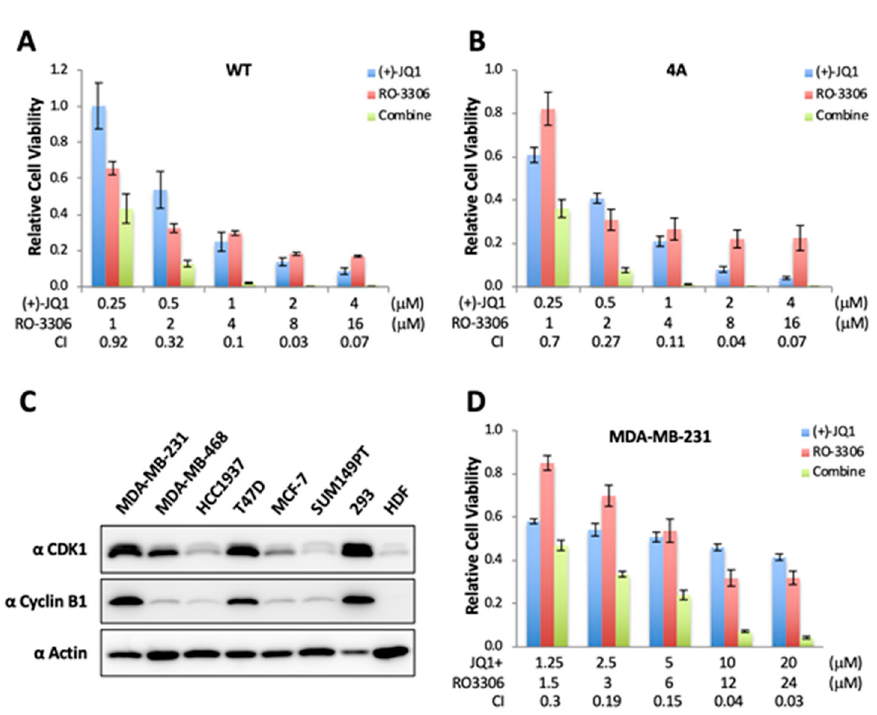
Figure 5. BETi and CDK1 inhibitor show synergistic e ff ects in killing cancer cells. ( A , B ) DLD-1 cells with CRISPRed BRD4-AID and Flp-In BRD4 WT ( A ) or 4A ( B ) were incubated with Dox and IAA for 1 day before treating with DMSO or the indicated doses of ( + )-JQ1, RO-3306 or a combination of both drugs. CellTiter-GLO cell viability assays were performed 3 days after drug treatment. Relative cell viability was determined by normalizing the drug treatment values to the DMSO control values. ( C ) Whole cell lysates of indicated breast cancer cells together with 293 and HDF cells were resolved in SDS / PAGE and immunoblotted with the indicated antibodies. ( D ) MDA-MB-231 cells were treated with DMSO or the indicated doses of ( + )-JQ1, RO-3306 or a combination of both drugs. CellTiter-GLO cell viability assays were performed 3 days after drug treatment. Relative cell viability was determined by normalizing the drug treatment values to the DMSO control values. CI values were analyzed with CompuSyn software.